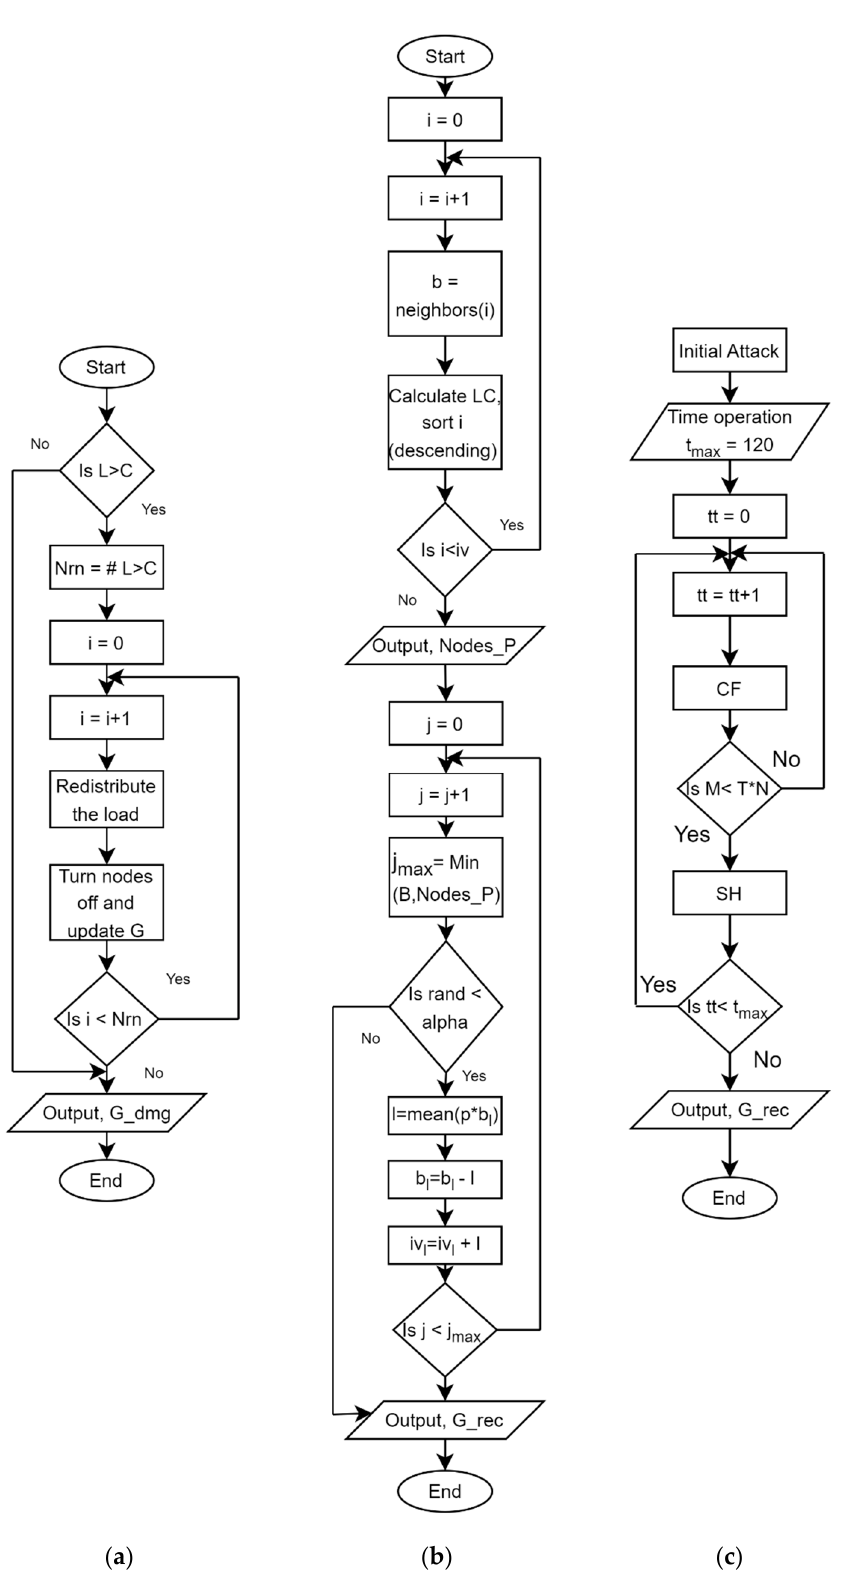
Figure 3. Flowcharts of key processes involved in the simulation. ( a ) CF; ( b ) SH; and ( c ) Main. There is another type of failure in the ESS-WH network (out of the scope of this work). It is caused by broken links between nodes. This can be due to the malfunctioning of the electric trucks in maintaining a full schedule of the MoBESS shipments back and